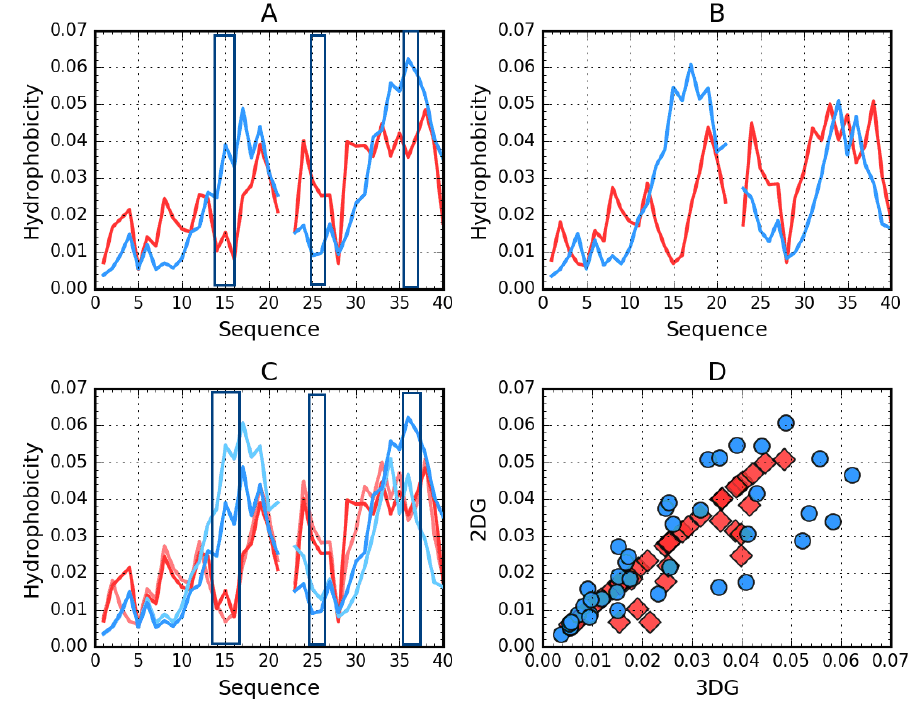
Figure 3. Theoretical (T, blue) and observed (O, red) hydrophobicity density profiles for Aβ( 1 – 40) (2MVX). A —3DG. B —2DG. C —3DG (darker) vs. 2DG (lighter) T and O distribution comparison—line (2MVX). A — 3DG. B — 2DG. C — 3DG (darker) vs. 2DG (lighter) T and O distribution plot. D —3DG vs. 2DG T (blue circles) and O (red rhombuses) distribution comparison—scatter plot. comparison — line plot. D — 3DG vs. 2DG T (blue circles) and O (red rhombuses) distribution The rectangles distinguish position of high discordance Ti versus Oi. The empty position in profiles comparison — scatter plot. The rectangles distinguish position of high discordance Ti versus Oi. The due to the Osaka mutation E22 empty position in profiles due to the Osaka mutation E22 Δ